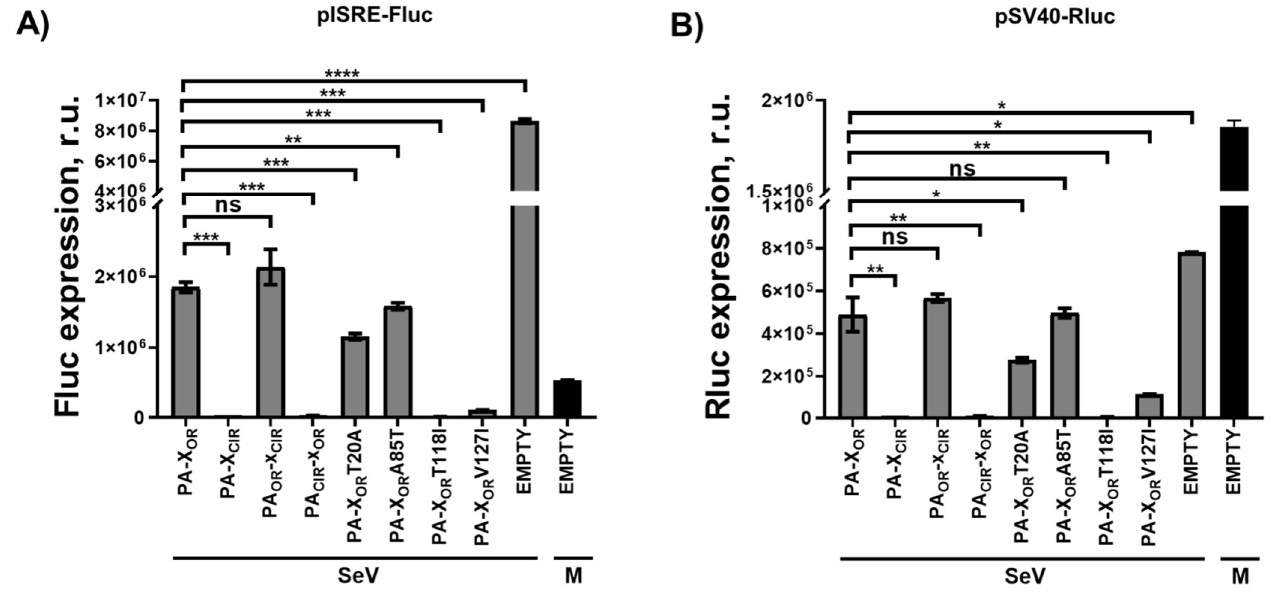
Figure 4. Effect of H5N1 NS1 and PA-X amino acid changes on IFN responses. ( A , B ) Human HEK293T cells were transiently co-transfected with a pCAGGS empty plasmid or with pCAGGS plasmids expressing the indicated HA epitope-tagged PA-X variants, together with a plasmid expressing Fluc under an ISRE dependent promoter, and a pCAGGS plasmid constitutively expressing Rluc. PA-X CIR protein encodes the amino acid changes T20A, A85T, T118I, I127V, G209E, V212A, L221R, and R250Q. PA OR -X CIR encodes the amino acid changes G209E, V212A, L221R, and R250Q. PA CIR -X OR encodes the amino acid changes T20A, A85T, T118I, and I127V. At 24 h.p.t, cells were infected with SeV (Cantell strain, MOI 3) or left mock-infected (M), and 20 h later expression of Fluc ( A ) and Rluc ( B ) was analyzed by luminescence. Data show the mean and standard deviations from cells in triplicate. ns, non-significant; *, p < 0.05; **, p < 0.005; ***, p < 0.0005; ****, p < 0.0001 using a Student’s t -test. Experiments were repeated 3 times in triplicate, with similar results. R.u., relative units.